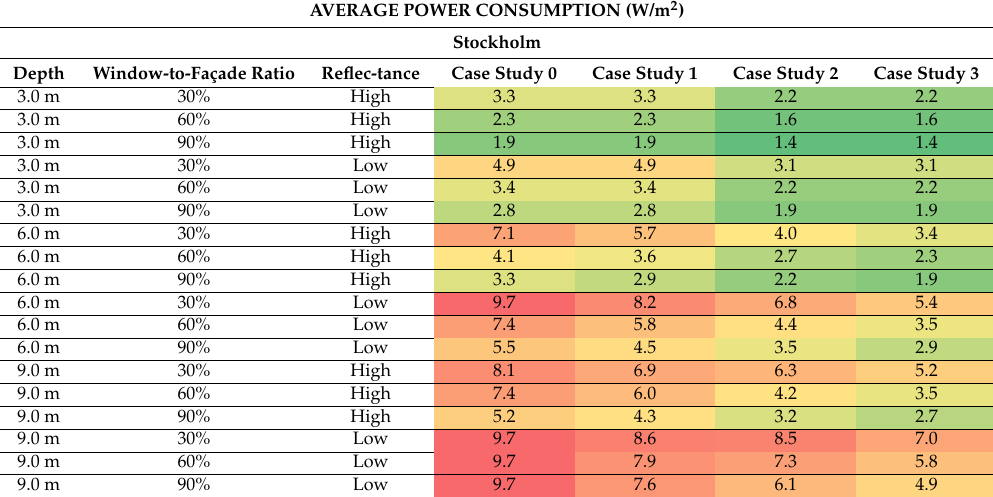
Table 6. Average power consumption in W/m 2 of different lighting smart controls in